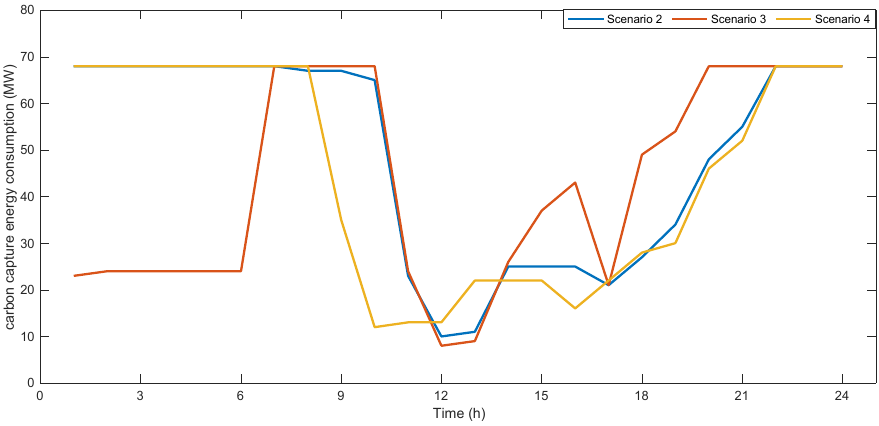
Figure 11. Comparison of carbon capture energy consumption.